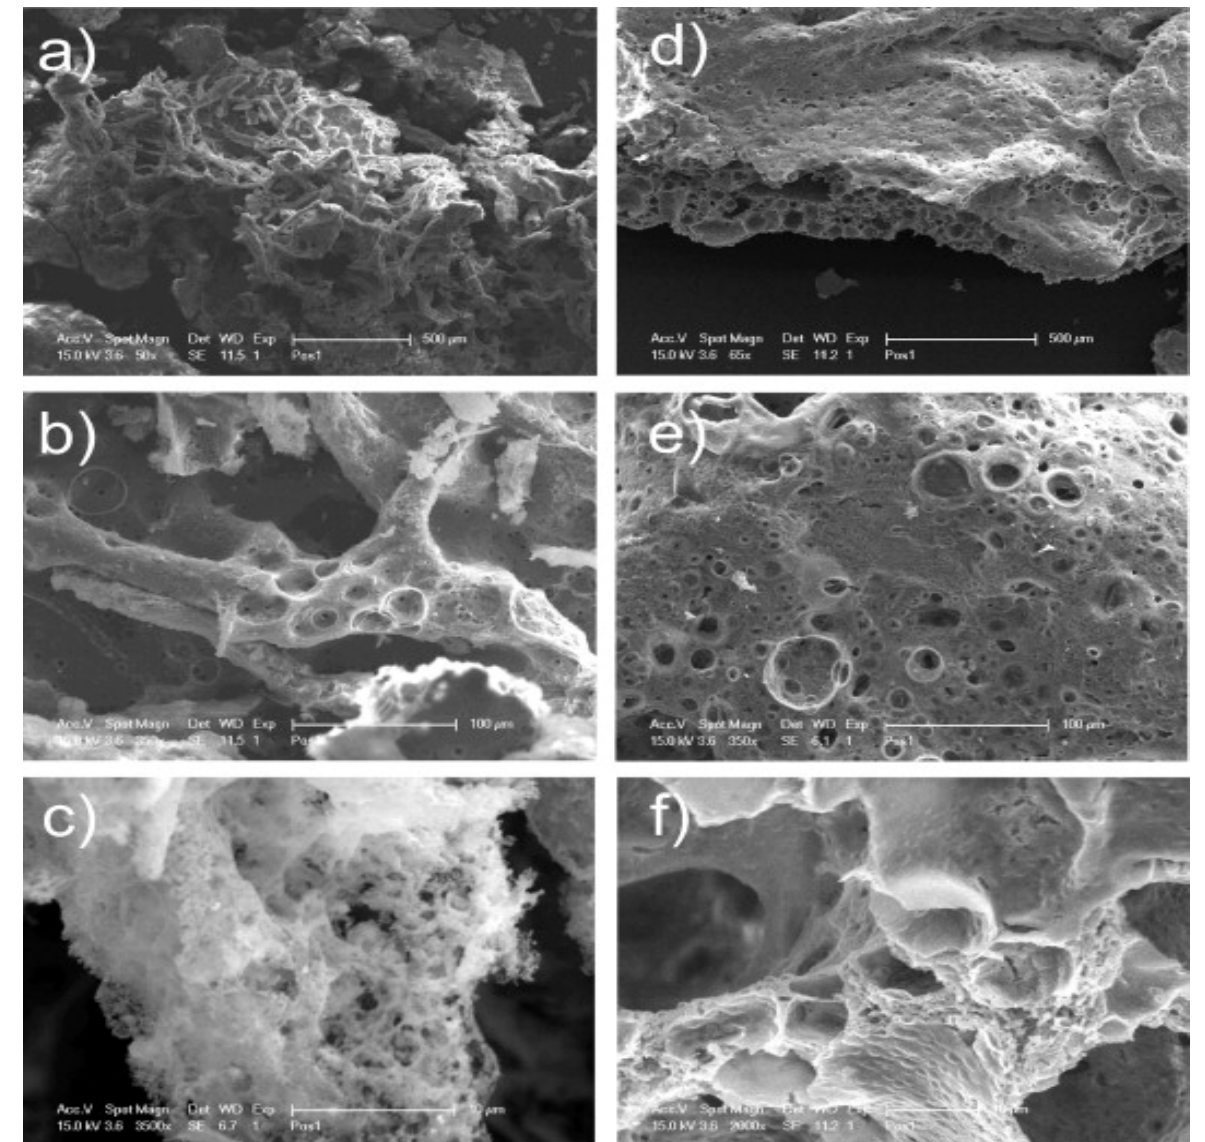
Figure 11. Microstructure of layered 2 ( a – c ) and Lam 1:6 ( d – f ) under numerous varied magnification scales. Reproduced with permission from [304].